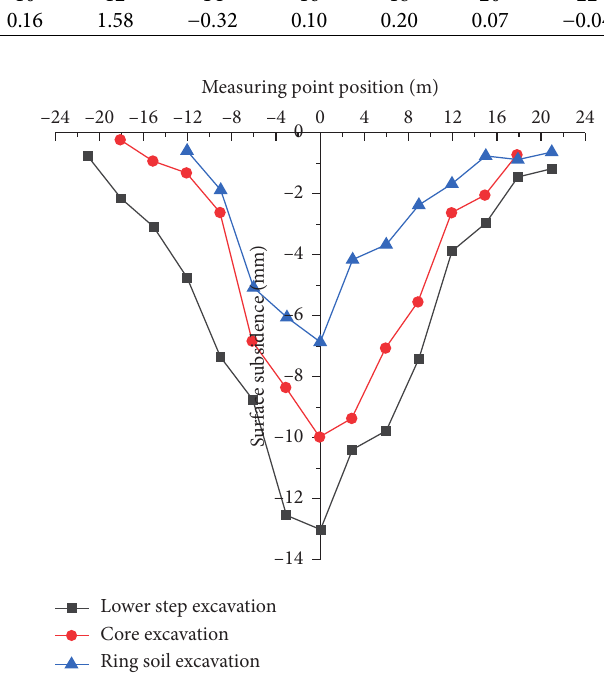
Figure 15: Distribution of surface settlement trough after the excavation of field